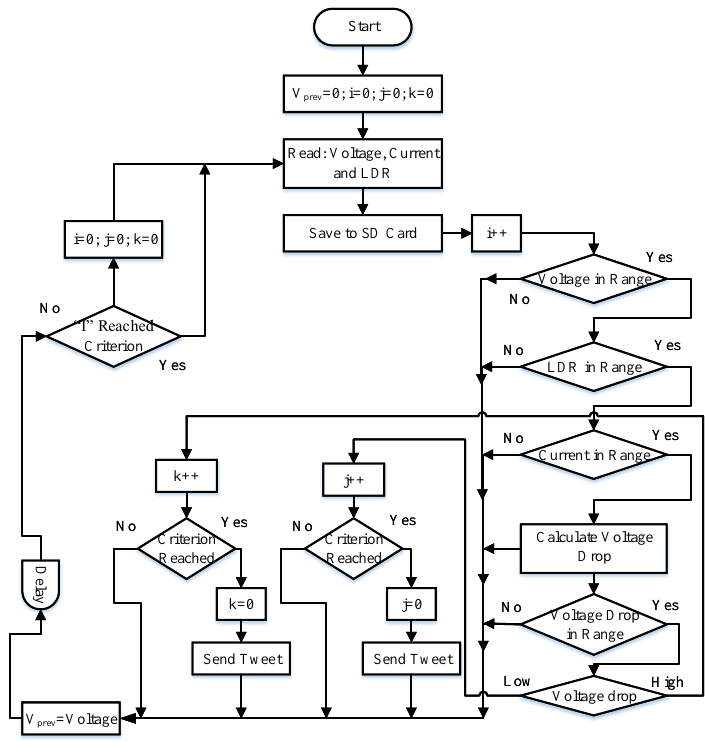
Figure 8. An algorithm to detect snowfall [87].